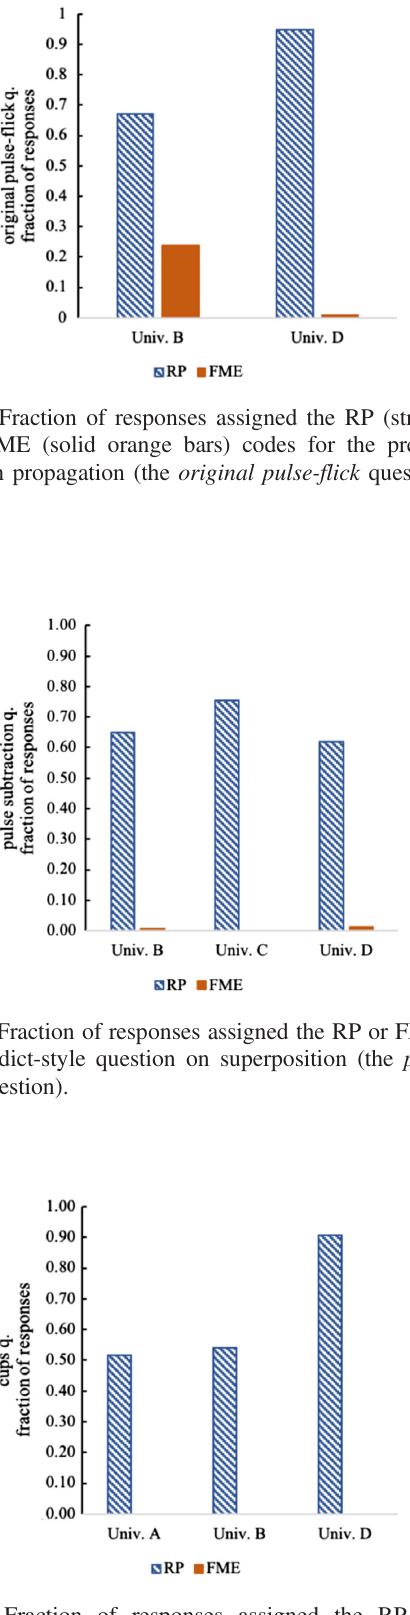
FIG. 17. Fraction of responses assigned the RP or FME